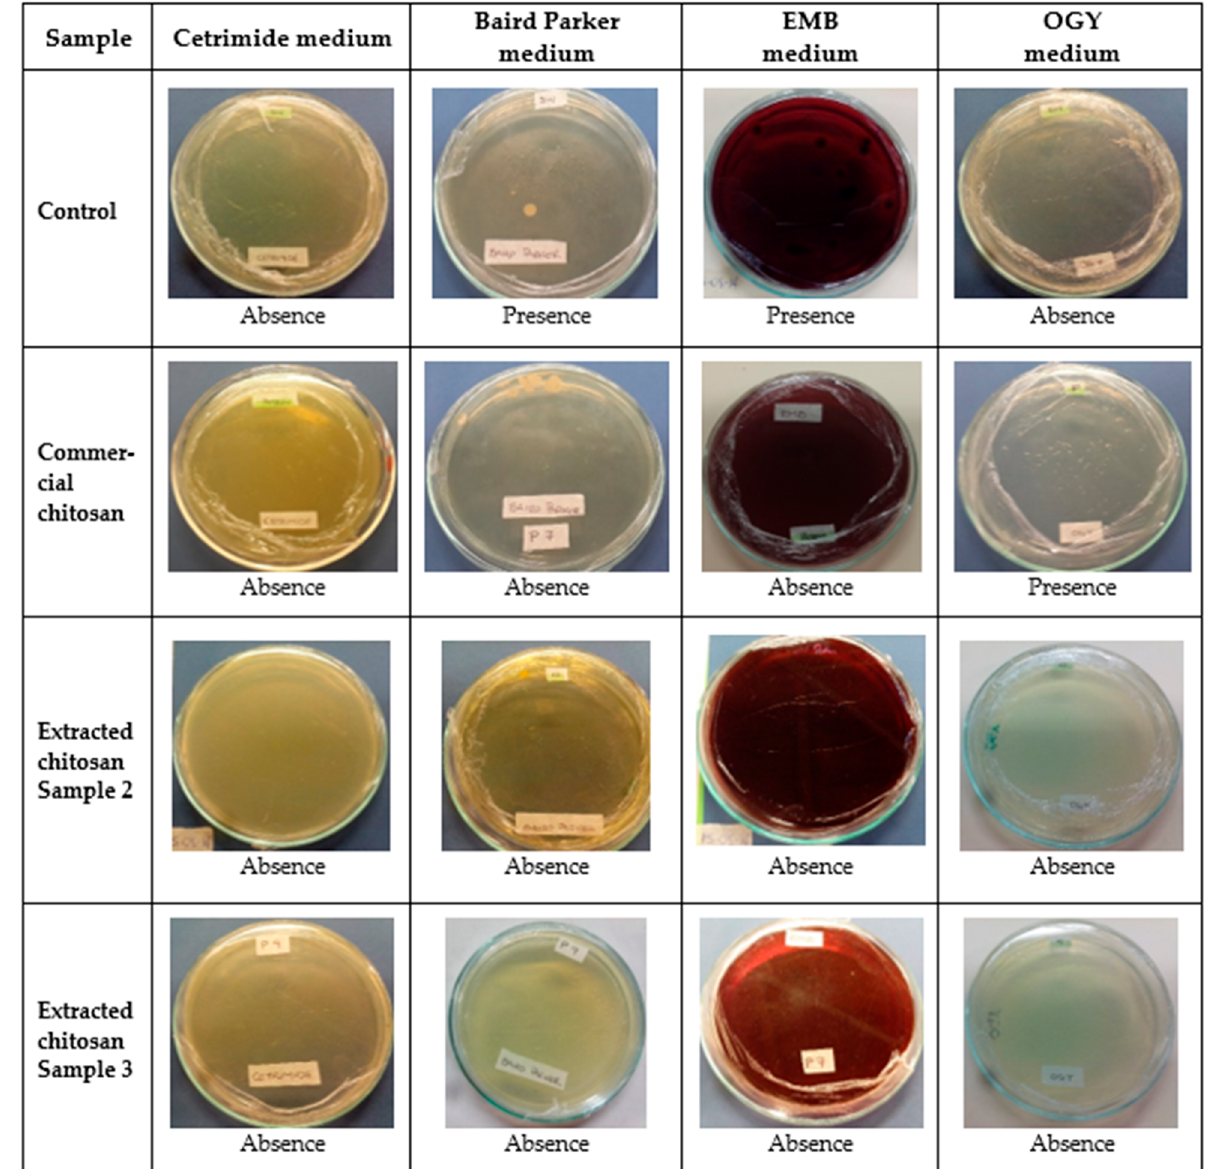
Figure 7. Microbial analysis of uncoated/coated feijoa after 15-day exposition.